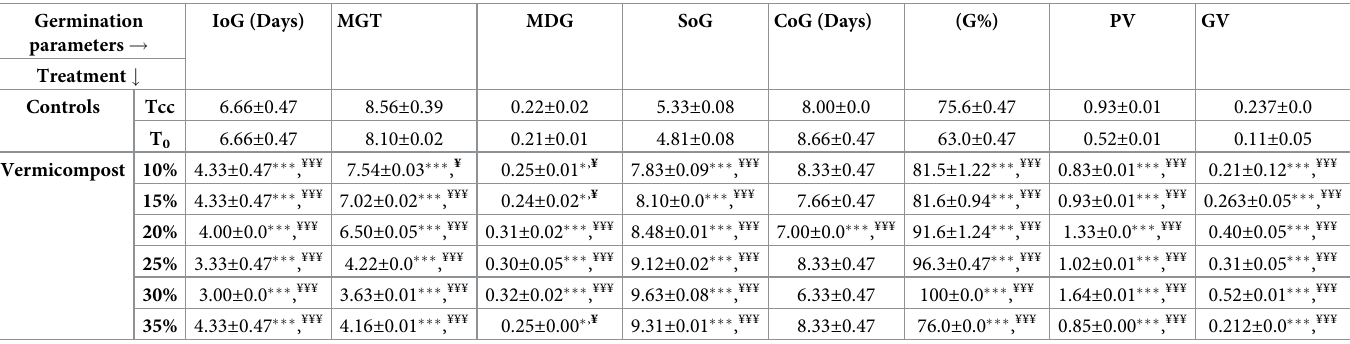
Table 2. Seed germination parameters in pansy under different compositions of germination media. Germination parameters